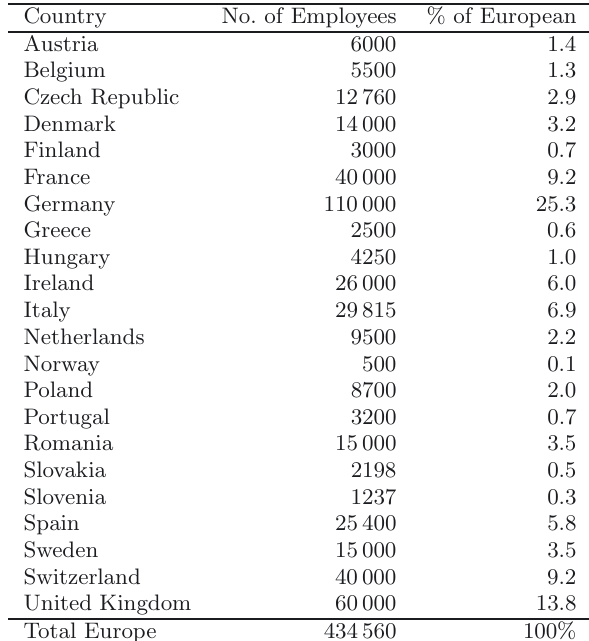
Table 1. European Medical Technology Employment. Source: Eucomed, ‘An introduction to the Medical Technology industry’